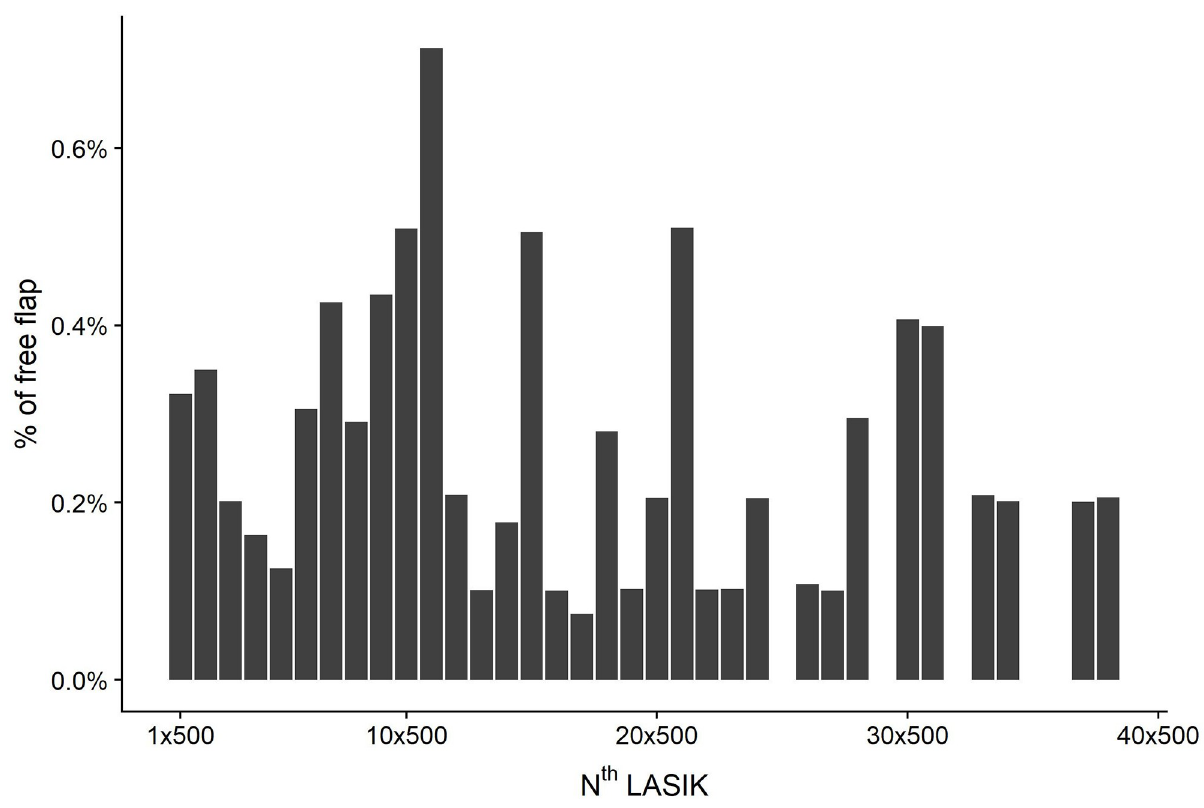
Fig 5. LASIK bins per surgeon and free flap